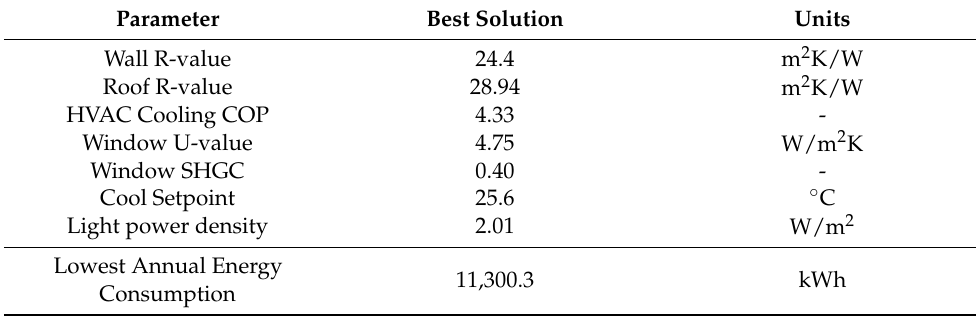
Table 7. Optimal design variables obtained from GA optimization.